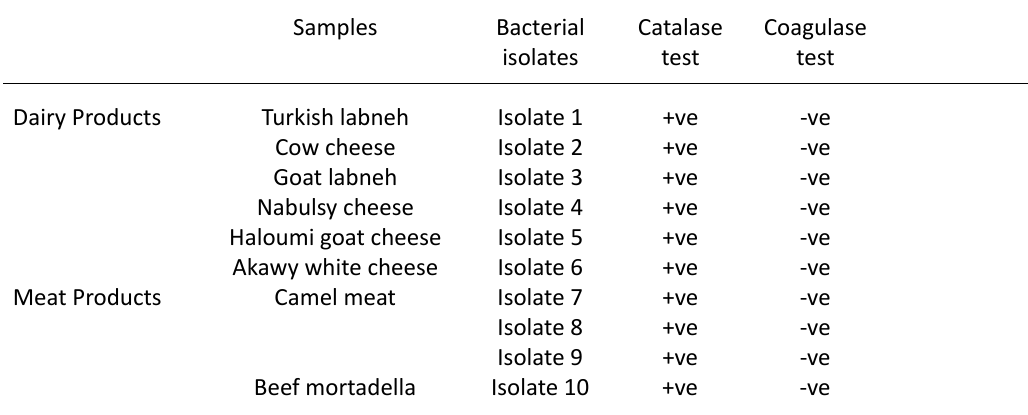
Table 1. Bacterial isolates in food products that produce catalase enzymes Samples